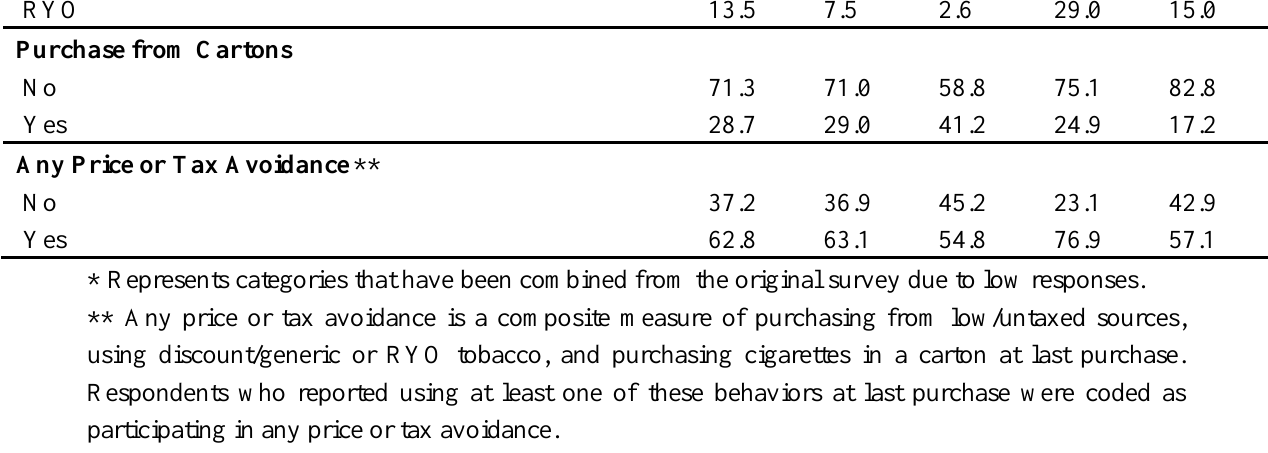
Weighted Percentage of Reported